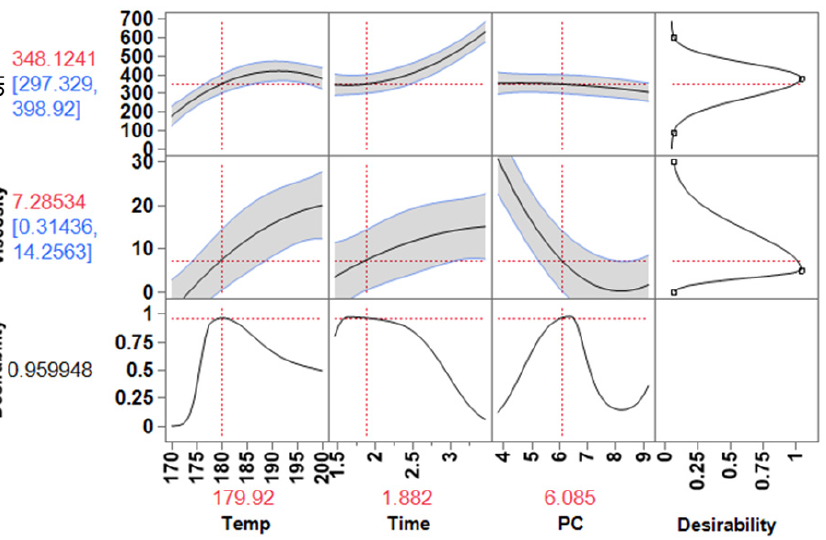
Figure 10. Prediction profiler and desired conditions for required I OH and viscosity of lignin-based polyol to produce rigid foams.